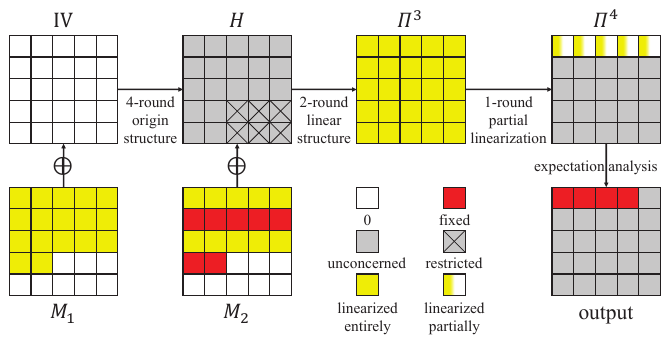
Figure 4: The outline of 4-round preimage